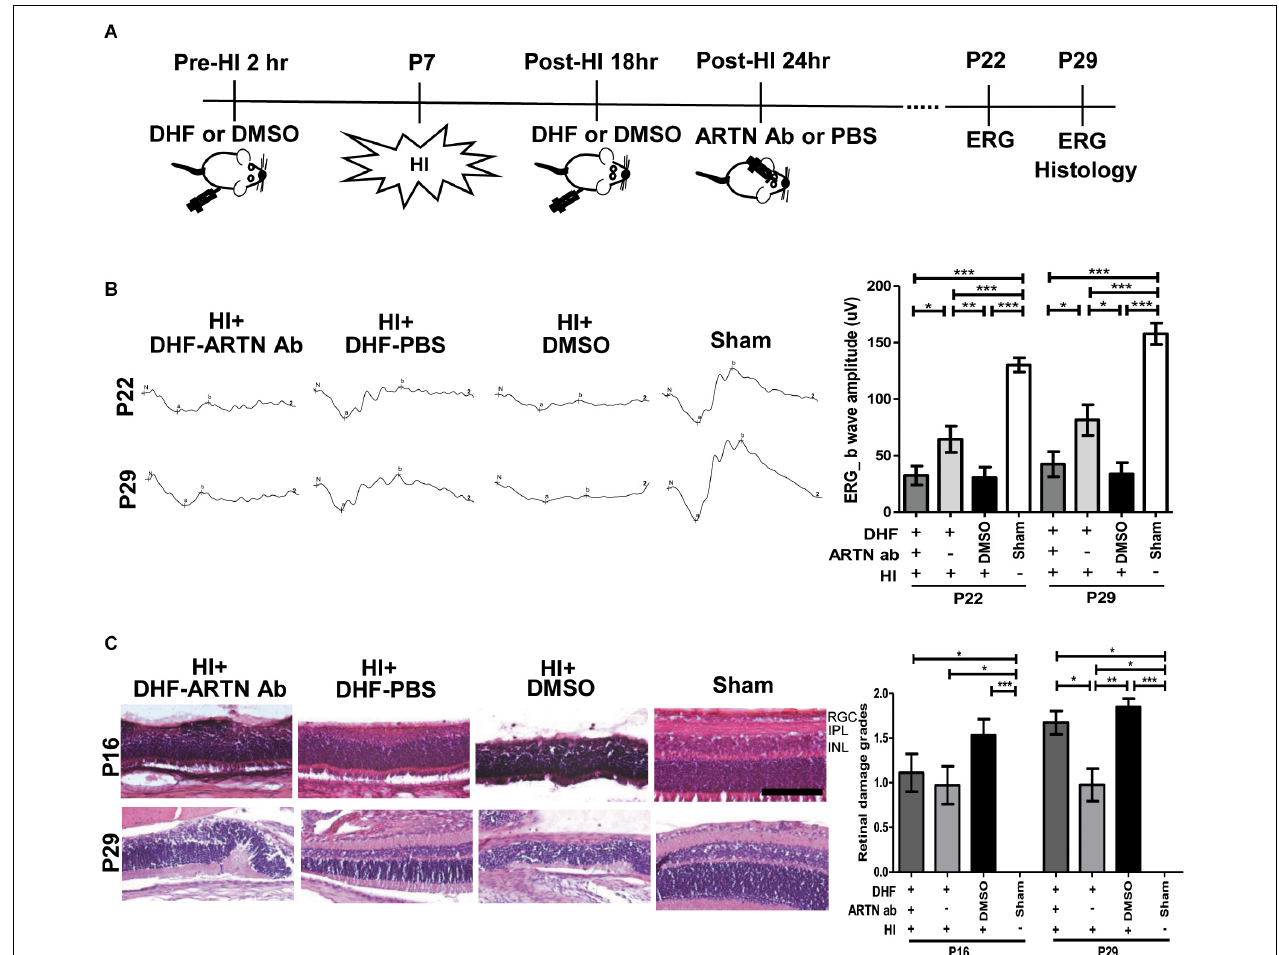
FIGURE 2 | Intravitreal injection of ARTN Antibody inhibits the functional and histological protection of systemic DHF in the HI-injured retinas. (A) Two hours before and 18 h after the HI, either DHF or DMSO was injected peritoneally. ARTN-Antibody (Ab) or PBS was injected intravitreally at post-HI 24 h. ERG or/and histology was performed at P22 and P29. (B) The retinal function evaluated using ERG demonstrated markedly depressed b-wave amplitudes in the HI injured groups at P22 and P29 as compared with the sham controls. The group data showed that the b-wave amplitude in the DHF-PBS group was significantly higher than that in the DHF-ARTN Ab and DMSO-treated groups after HI at P22 and P29. (C) Representative retinal histologic sections showed that the number of RGCs and the thickness of IPL and INL decreased after HI at P16 and P29. The group data showed that the grades of retinal damage were significantly higher in the HI groups than in the sham controls at P16 and P29. There were no significant differences between the DHF-PBS, DMSO, and DHF-ARTN Ab groups after HI injury at P16. As compared with the DHF-PBS group, the DMSO and DHF-ARTN Ab groups exhibited increased retinal damage grades at P29. Scale bars: 100 µ m; n = 4–13 per group in each time point, power = 0.8, * p < 0.05, ** p < 0.01, *** p <